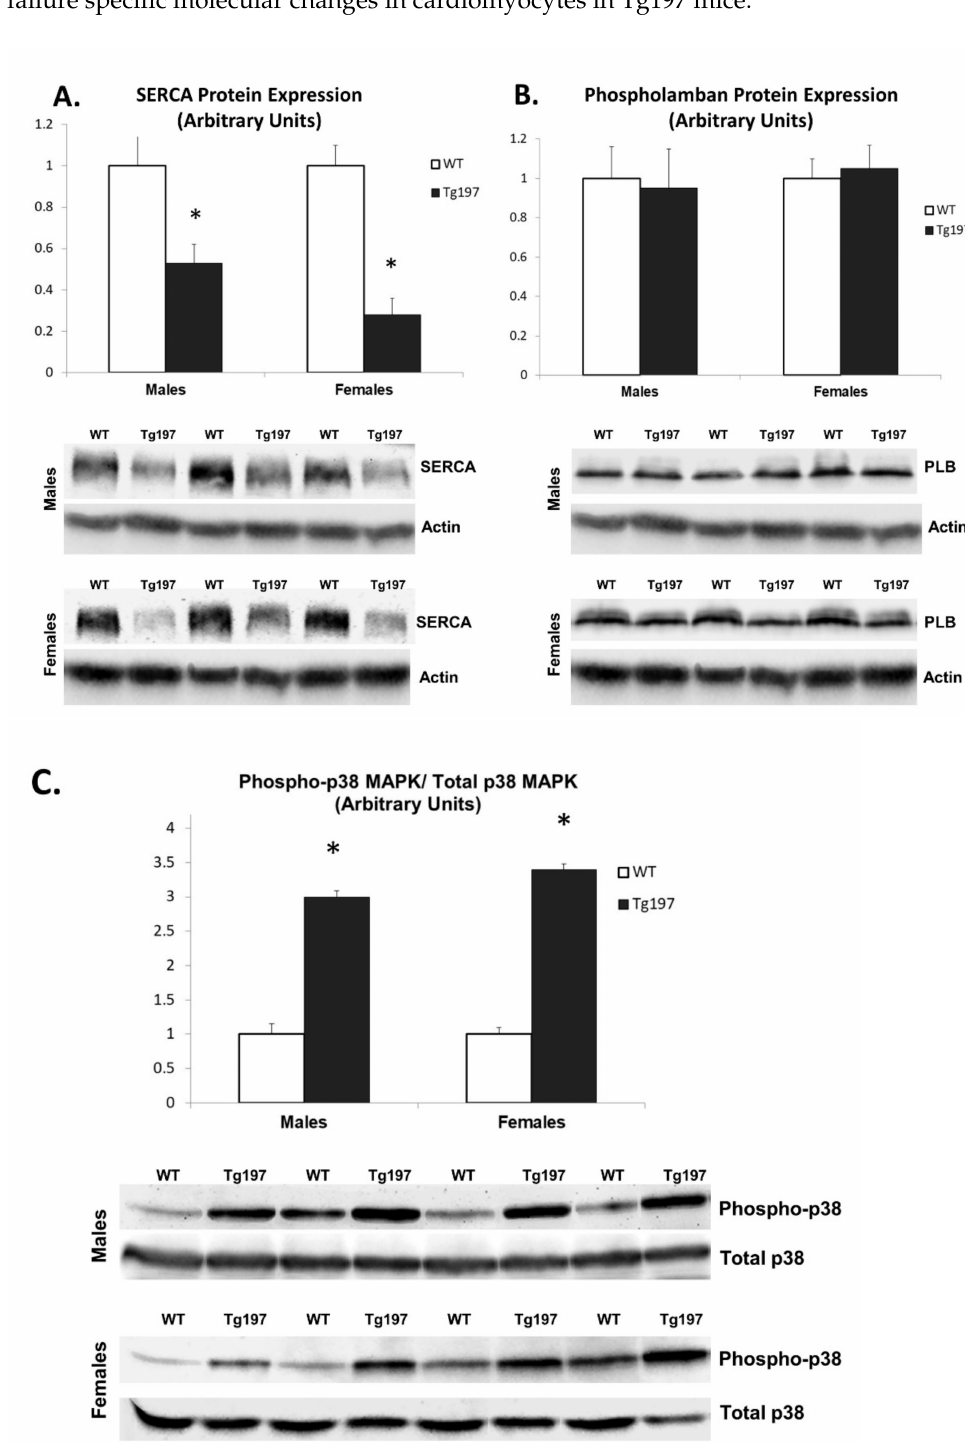
Figure 1. Reduced SERCA and increased activation of p38 MAPK in Tg197 LV samples. Densit- ometric assessment in arbitrary units and representative images of SERCA2a protein expression ( A ), PLB protein expression ( B ) and phosphorylated and total p38 MAPK ( C ) in left ventricle of WT C57BL/6JxCBA (WT, n = 4 for each gender) and Tg197 ( n = 6 for each gender) male and female mice. Values are represented in mean ± SEM; * p < 0.05. (SERCA: Sarcoplasmic Reticulum–Calcium ATPase, PLB: Phospholamban, LV: left